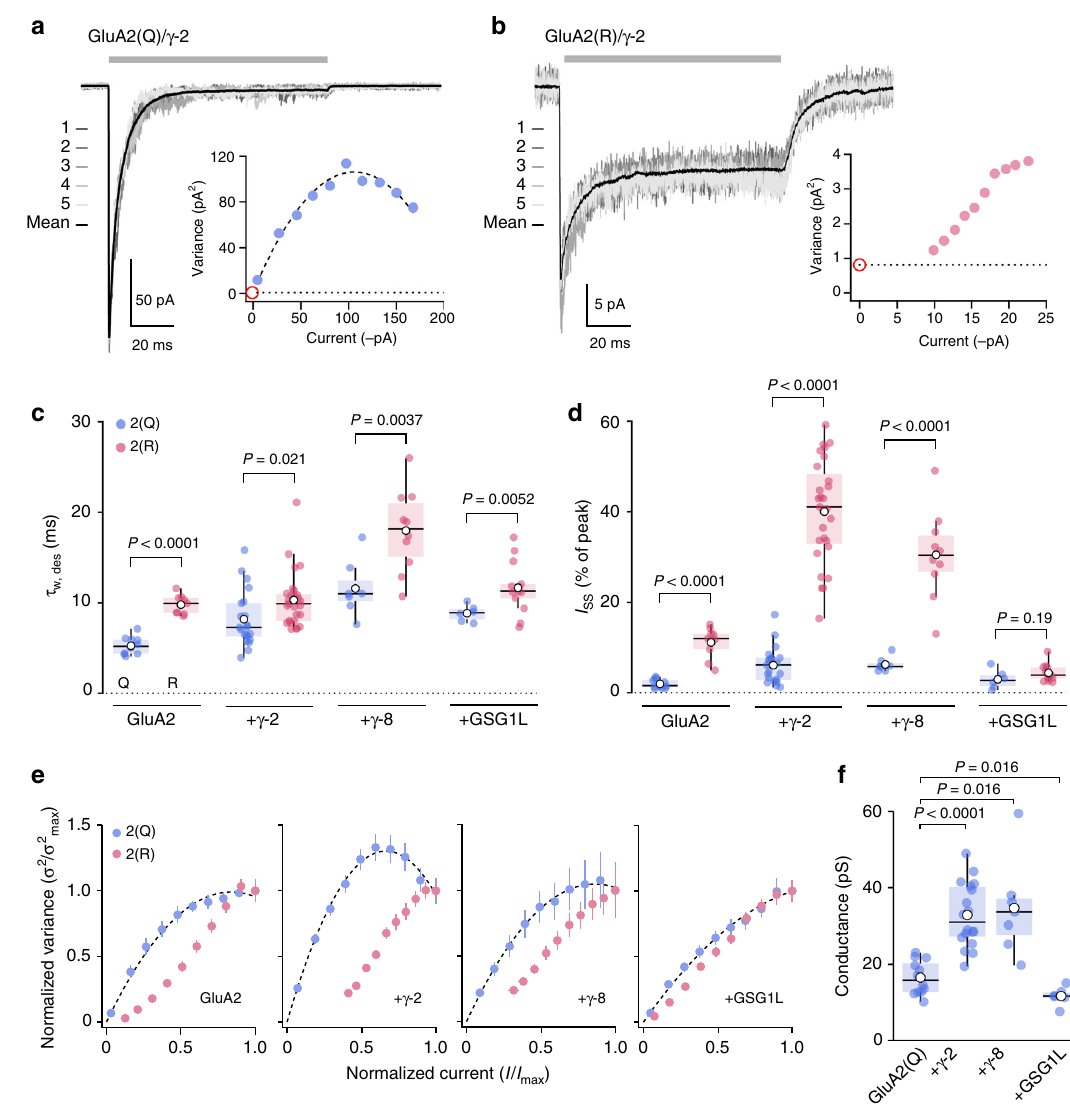
Fig. 1 Q/R editing affects the kinetics and variance of GluA2 currents. a Representative outside-out patch response (10 mM glutamate, 100 ms, – 60 mV; gray bar) from a HEK293 cell transfected with GluA2(Q)/ γ -2 (average current, black; fi ve individual responses, grays). Inset: current – variance relationship (dotted line indicates background variance and red circle indicates expected origin). b As a , but for GluA2(R)/ γ -2. Note that the data cannot be fi tted with a parabolic relationship passing through the origin. c Pooled τ w,des data for GluA2 alone ( n = 12 Q-form and 9 R-form), GluA2/ γ -2 ( n = 21 and 27), GluA2/ γ -8 ( n = 7 and 10), and GluA2/GSG1L ( n = 6 and 13). Box-and-whisker plots indicate the median (black line), the 25 – 75th percentiles (box), and the 10 – 90th percentiles (whiskers); fi lled circles are data from individual patches and open circles indicate means. Two-way ANOVA revealed an effect of Q/R editing ( F 1,97 = 111.34, P < 0.0001), an effect of auxiliary subunit type ( F 3,97 = 32.3, P < 0.0001) and an interaction ( F 3,97 = 2.84, P = 0.041). d Pooled data for I ss . Box-and-whisker plots and n numbers as in c . Two-way ANOVA indicated an effect of Q/R editing ( F 1,97 = 129.98, P < 0.0001), an effect of auxiliary subunit type ( F 3,97 = 58.30, P < 0.0001), and an interaction ( F 3,97 = 58.67, P < 0.0001). e Doubly normalized and averaged current – variance relationships (desensitizing current phase only) from GluA2(Q) and GluA2(R) expressed alone ( n = 12 and 9), with γ -2 ( n = 19 and 23), with γ -8 ( n = 7 and 10), or with GSG1L ( n = 6 and 13). Error bars are s.e.m.s. All Q-forms can be fi tted with parabolic relationships passing through the origin, while R-forms cannot. f Pooled NSFA conductance estimates for GluA2(Q) alone, GluA2(Q)/ γ -2, GluA2(Q)/ γ -8, and GluA2(Q)/GSG1L ( n = 12, 18, 7, and 6, respectively). Box- and-whisker plots as in c . Indicated P values are from Wilcoxon rank sum tests. Source data are provided as a Source Data fi